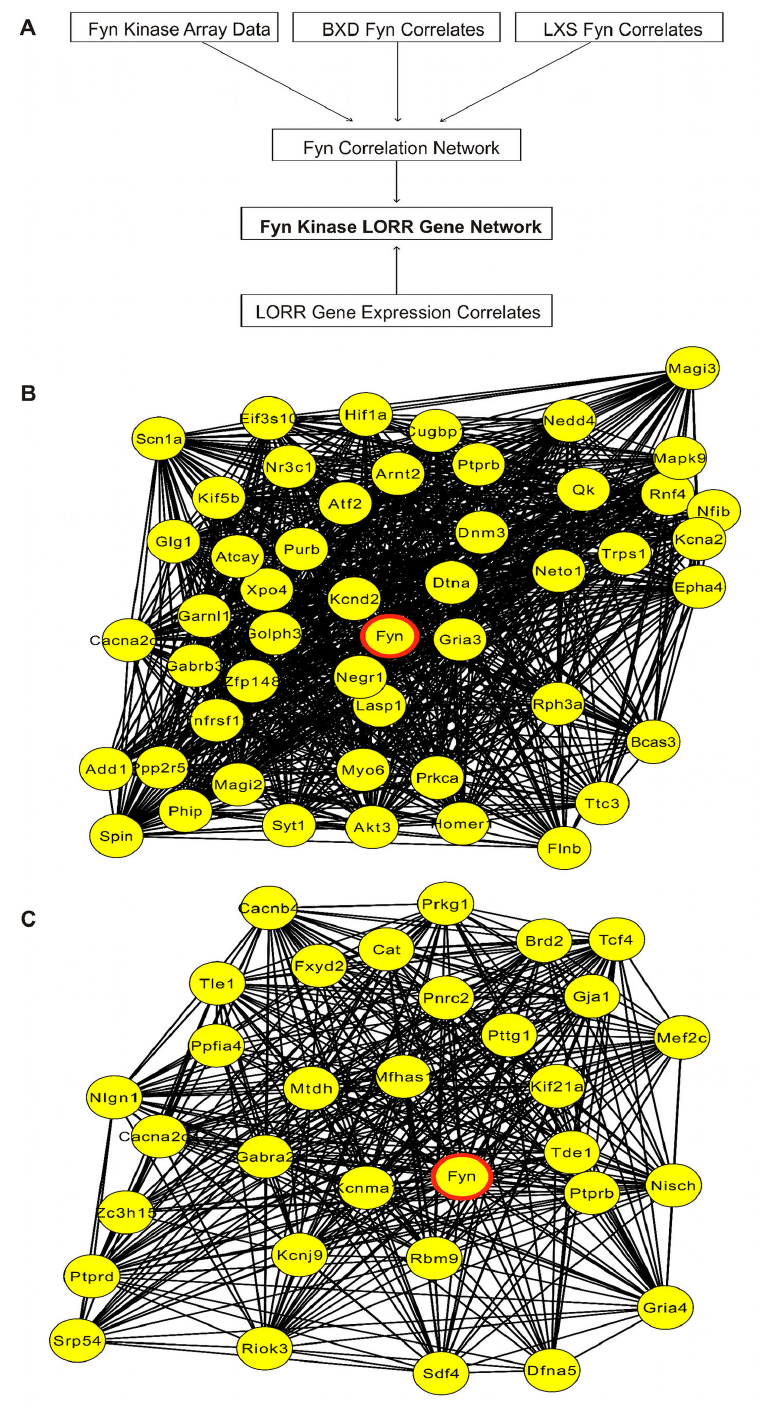
Figure 4. Fyn-LORR Correlation Network within PFC. Network analysis of concurrent variation of gene expression amongst PFC Fyn knockout array data, Fyn expression correlates across the BXD RI PFC, Fyn expression correlates across the LXS RI PFC, and LORR – BXD gene expression correlates in PFC. (A) Diagram of general approach used to define a Fyn-dependent gene network for the loss of righting reflex behavior. (B) Basal Fyn-dependent gene network showing correlations among BXD RI RMA saline dataset (node connections indicate correlation p-value ≤ 0.01). (C) Ethanol-responsive Fyn-dependent gene network showing correlations among BXD RI S-score dataset (p-value ≤ 0.01). Red circle indicates position of Fyn . doi: 10.1371/journal.pone.0082435.g004 PLOS ONE |